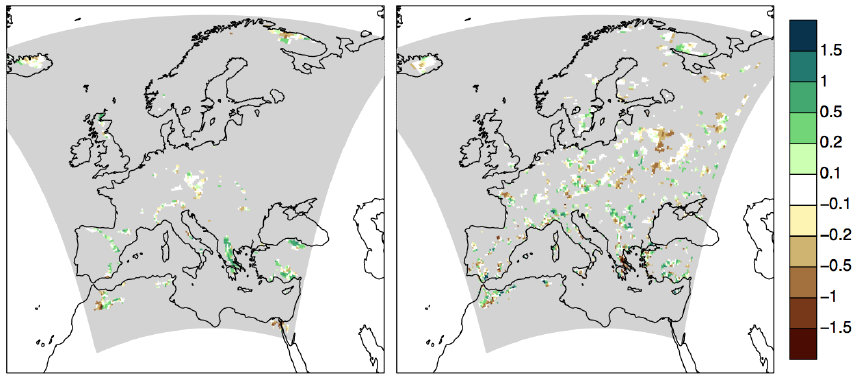
Figure 4. Reduction in absolute trend bias by the non-local approach. Trends measured in percent per decade. Left panel: DJF; right panel: JJA. Green: improvement (bias reduced); brown: deterioration (bias increased). Areas where correlation does not improve by at least 0.2 are shown in grey. As the cross-validation would cause inhomogeneities, trends are calculated without cross-validation.